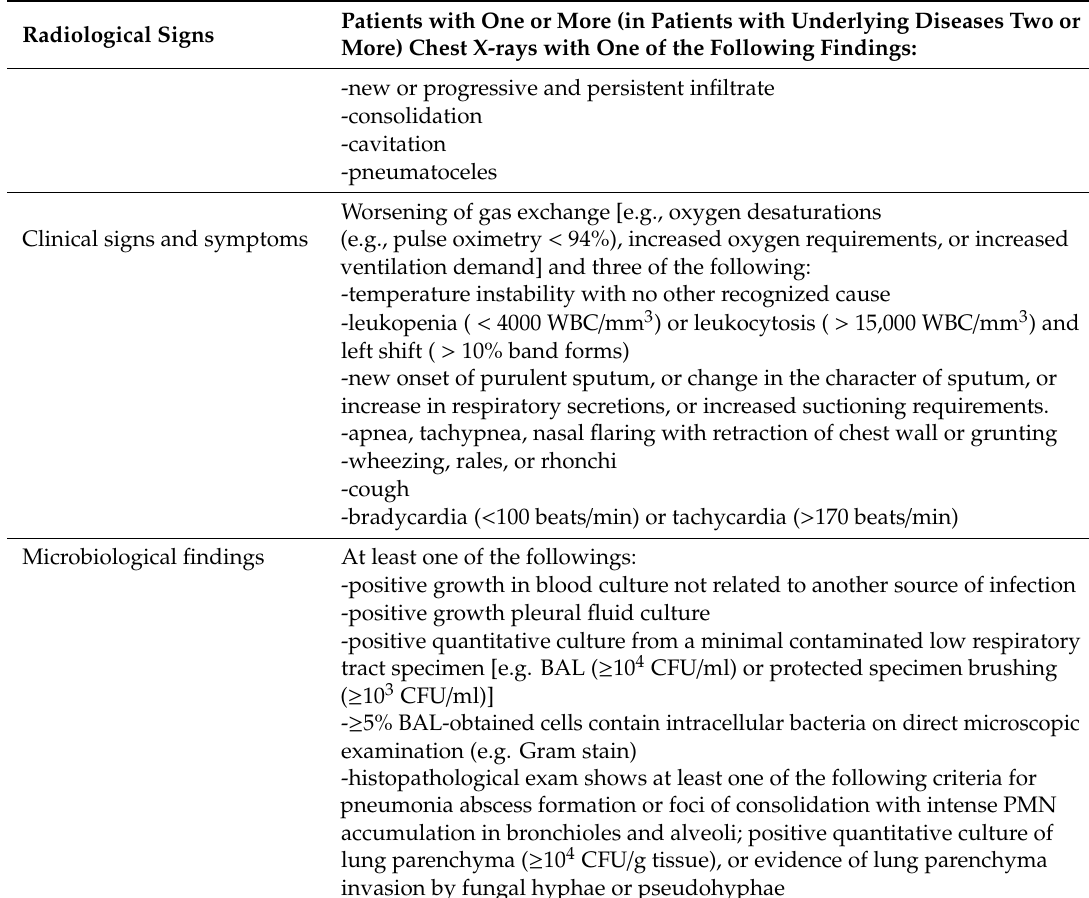
Table A1. Diagnostic criteria for neonatal ventilator-associated pneumonia in this study, based on the CDC criteria